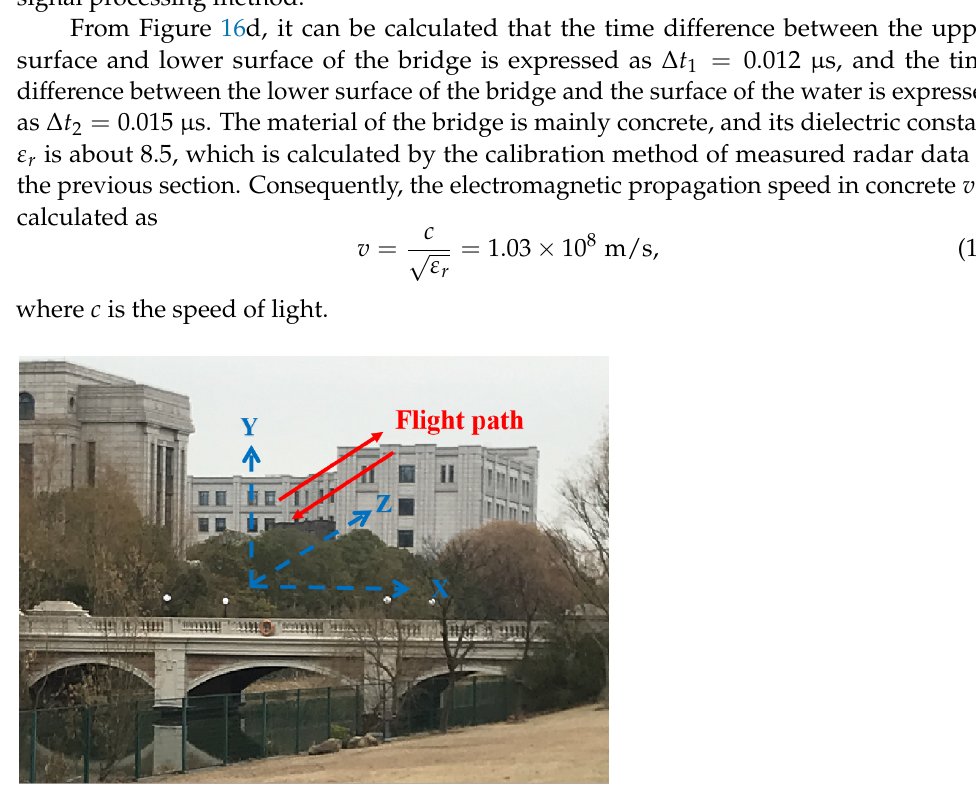
Figure 15. The experimental scene of a bridge. The UAV-GPR flies in Z direction, where the Z direction is pointing in the direction perpendicular to the